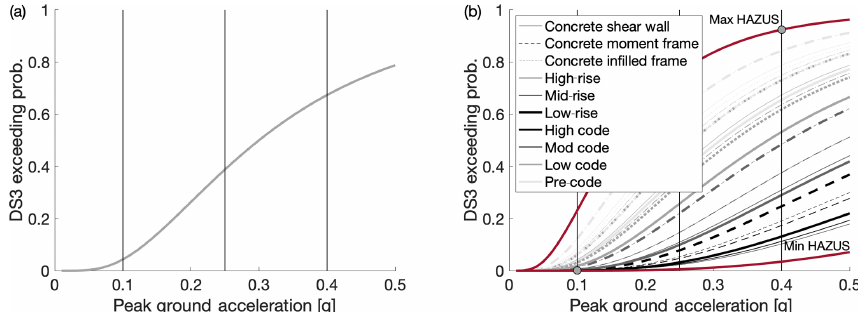
Figure 2. (a) Example baseline score for a given archetype building typology. (b) HAZUS fragility curve database related to the extensive damage limit state for RC